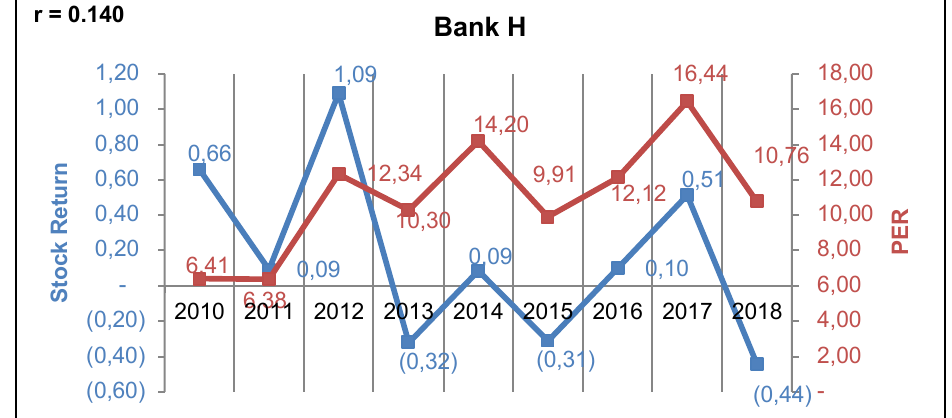
Figure 8: For Bank H Bank H had similar trends as Bank A and Bank